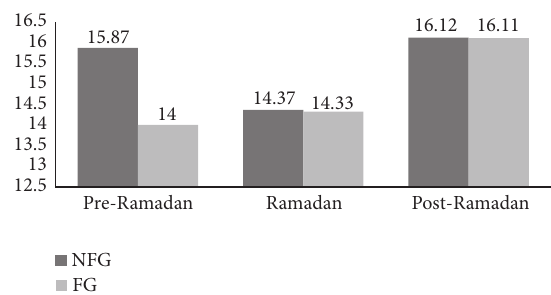
Figure 1: Digit span test (DST) scores at three occasions in both fasting group (FG) and nonfasting group